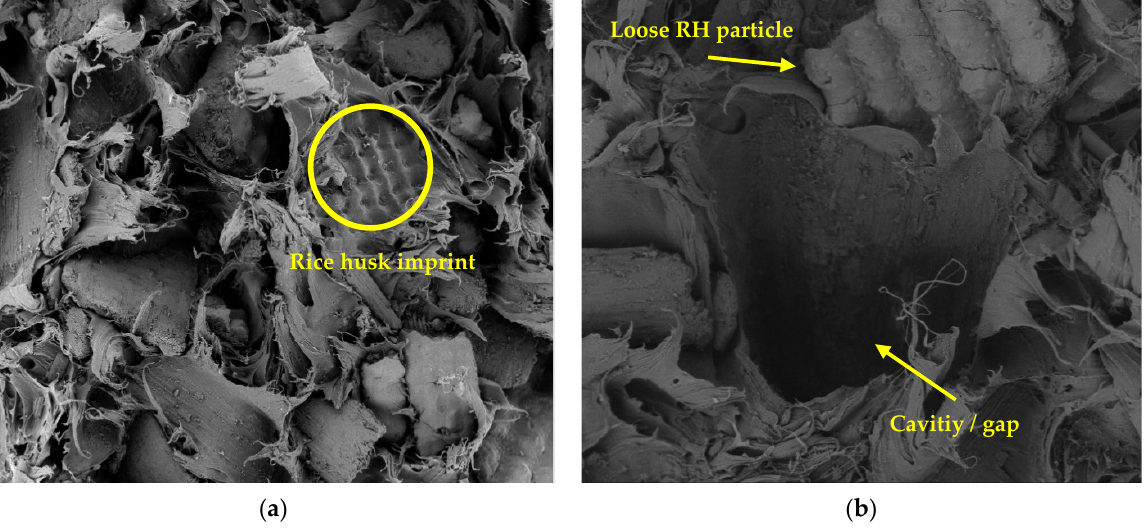
Figure 8. SEM micrographs for reinforced composite rHDPE/RH 1 ( a ) 200× and ( b ) 400× magnifica- tion.